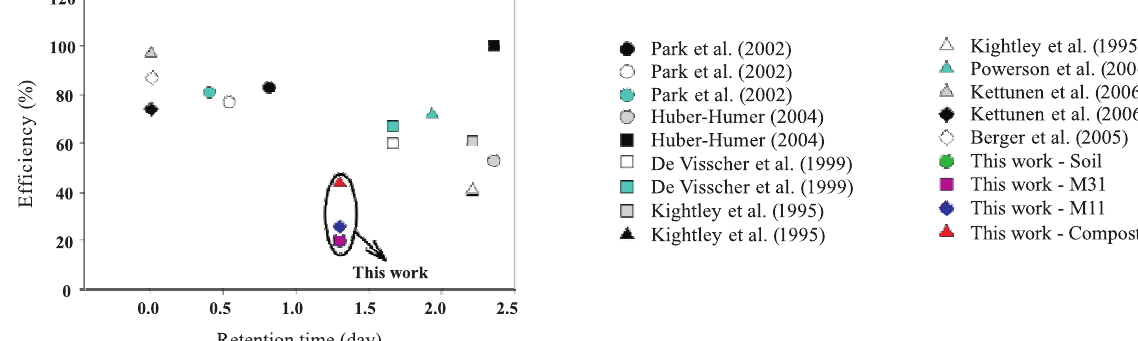
figure 8. Biofilter efficiency versus retention time, as reported in the literature and in this